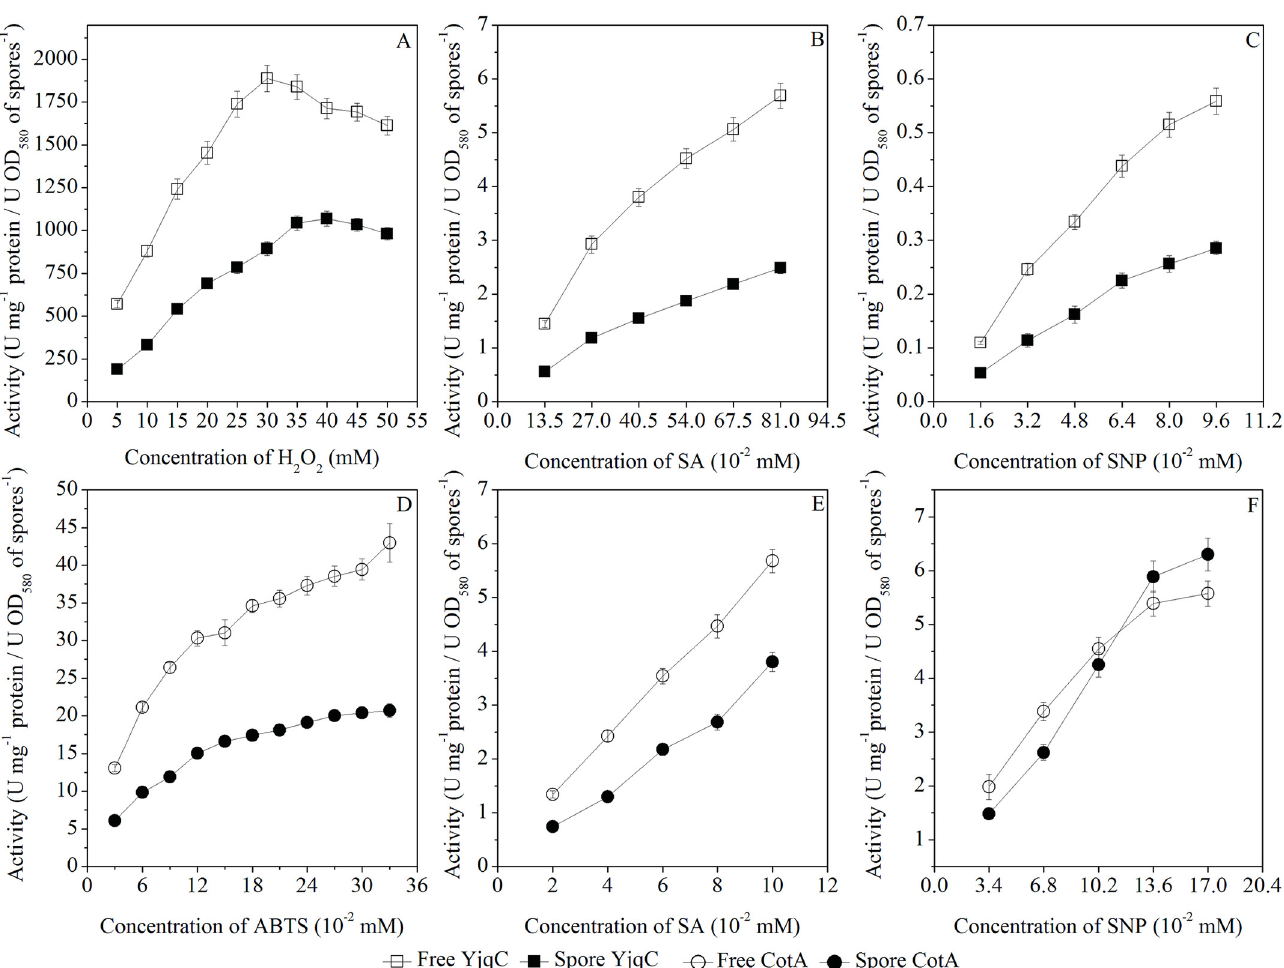
Fig 4. Effects of substrate concentrations on enzyme activity. Catalase activity of the free and spore YjqC under different concentrations of H 2 O 2 (A). Peroxidase activity of the free and spore YjqC toward different concentrations of SA (B) and SNP (C). Laccase activity of the free and spore CotA toward different concentrations of ABTS (D), SA (E) and SNP (F).